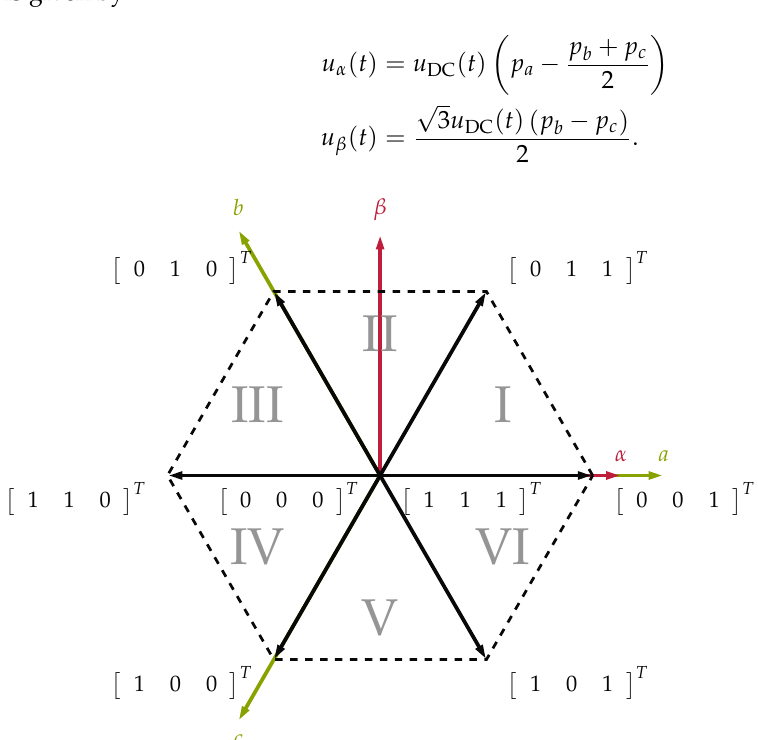
Figure 8. Hexagon of a two-level converter and stationary reference frames.